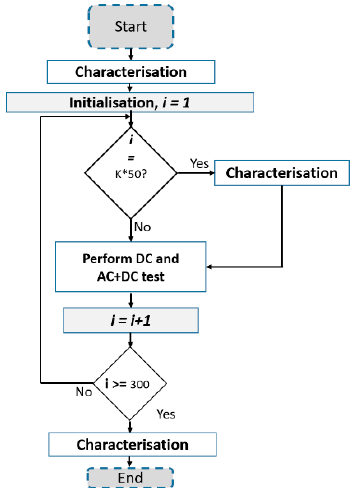
Figure 5. Experimental procedure.